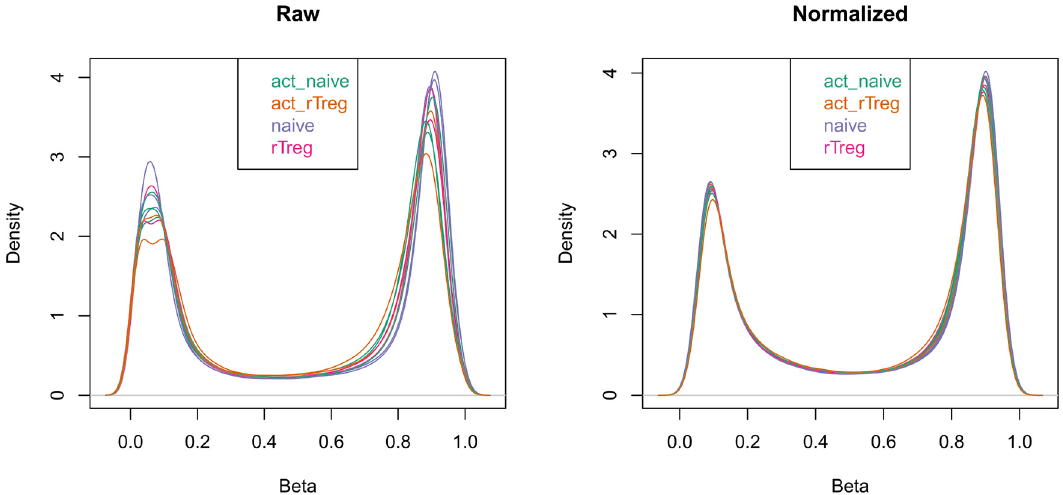
Figure 3. The density plots show the distribution of the beta values for each sample before and after